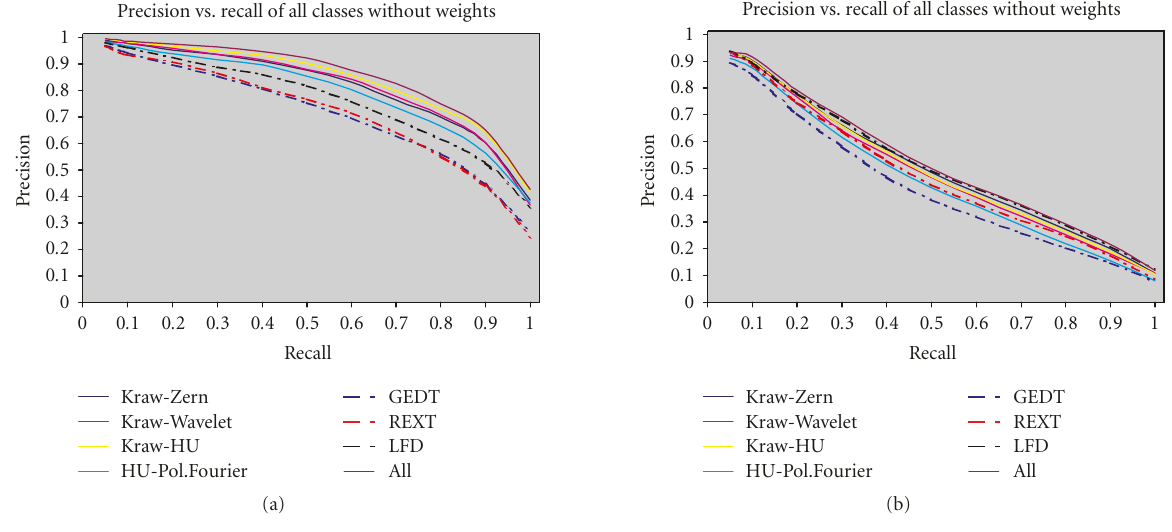
Figure 5: Precision-recall curves diagram: some of the best descriptor vector combinations, using the new database (a) and the Princeton database (b).